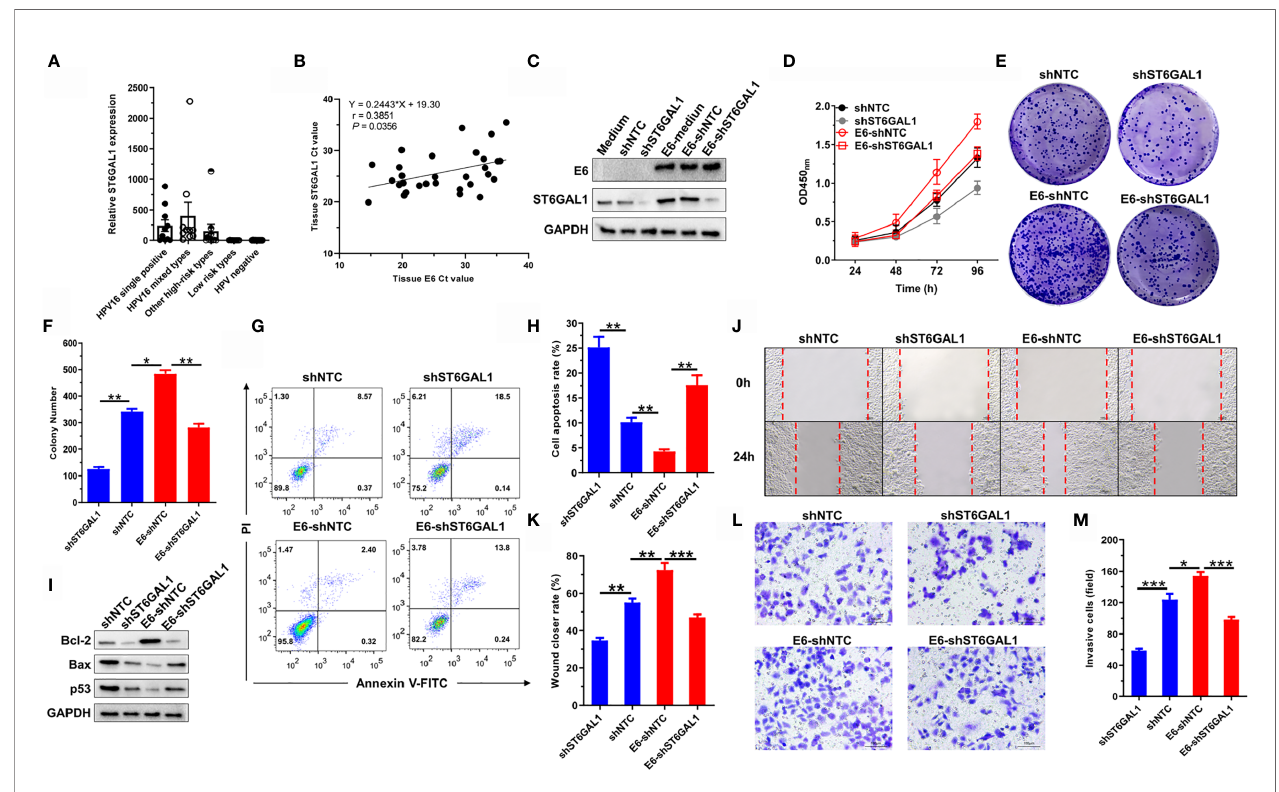
FIGURE 2 | ST6GAL1 is a pivotal oncogenic mediator of the high-risk HPV 16 E6. (A) Analysis of ST6GAL1 expression in cervical scraping samples of fi ve patient groups (n = 10 in each group). HPV-negative samples were used as control group, and ST6GAL1 expression values were normalized relative to expression of the housekeeping gene GAPDH by the 2 − DD Ct method. (B) The association of ST6GAL1 to E6 in E6-detected samples was analyzed by Spearman analysis (n = 30). (C) C33A and C33A-E6 (E6 stable expressing) cells were transiently transfected with short hairpin RNA targeting ST6GAL1 (shST6GAL1) or a non-targeting control (shNTC). Then, protein expression of E6 and ST6GAL1 were detected by Western blot. (D) Proliferation of indicated cells were detected by CCK-8 assay. (E) The clones of indicated cells were visualized by crystal violet staining. (F) Statistical analysis of colony numbers in C33A and C33A-E6 cells. (G, H) Apoptosis of indicated cells were detected by fl ow cytometry, and then, apoptotic rates were statistically analyzed. (I) Western blot was used to detect the expression of apoptosis-related proteins. (J, K) Migrative abilities of indicated cells were detected by wound-healing assay and statistically analyzed. (L, M) Invasive abilities of indicated cells were detected by Transwell assay and statistically analyzed. Data were presented as mean ± SD from the three independent replicates. * p < 0.05; ** p < 0.01; *** p <